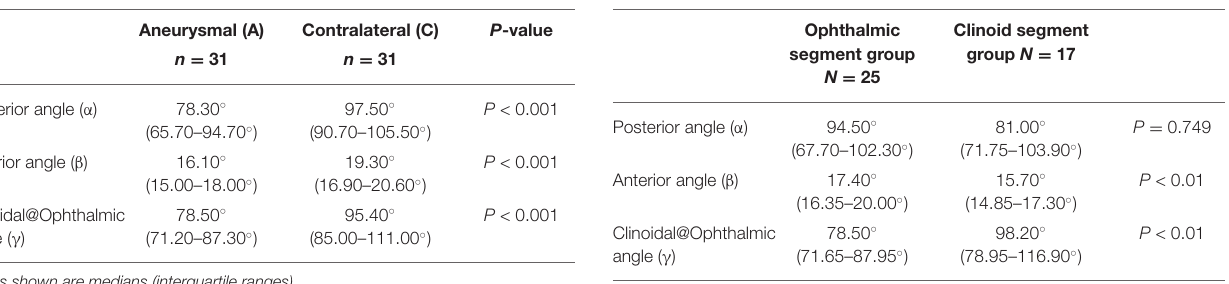
Values shown are medians (interquartile